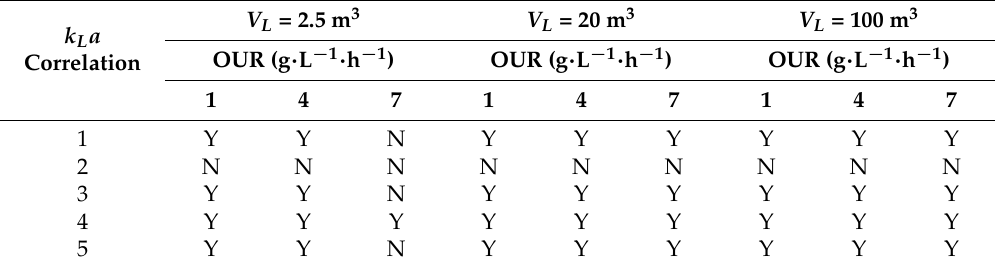
Table 3. Influence of k L a correlation (Table 2), working volume ( V L ) and OUR on whether or not minimum total power occurs at the onset of flooding in Scenario Cmin —Y: yes, minimum total power occurs at onset of flooding; N: no, it does not ( C OL = 2 mg · L − 1 ).